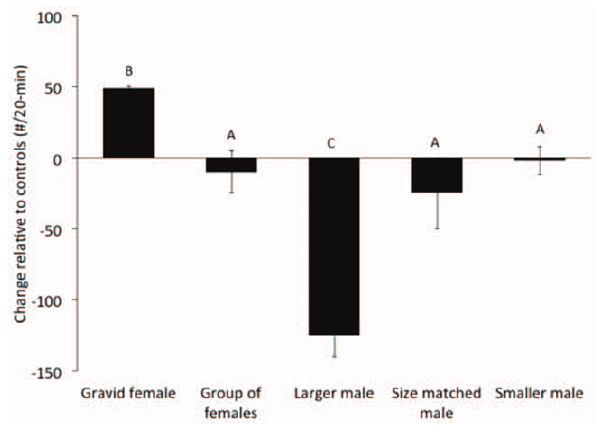
Figure 5. Aggressive displays and postures. Number of aggressive displays and postures by signaling males in the presence of different audiences. The number of over aggressive acts varied across all audience types and the letters above the bars represent significant differences at a =0.05.